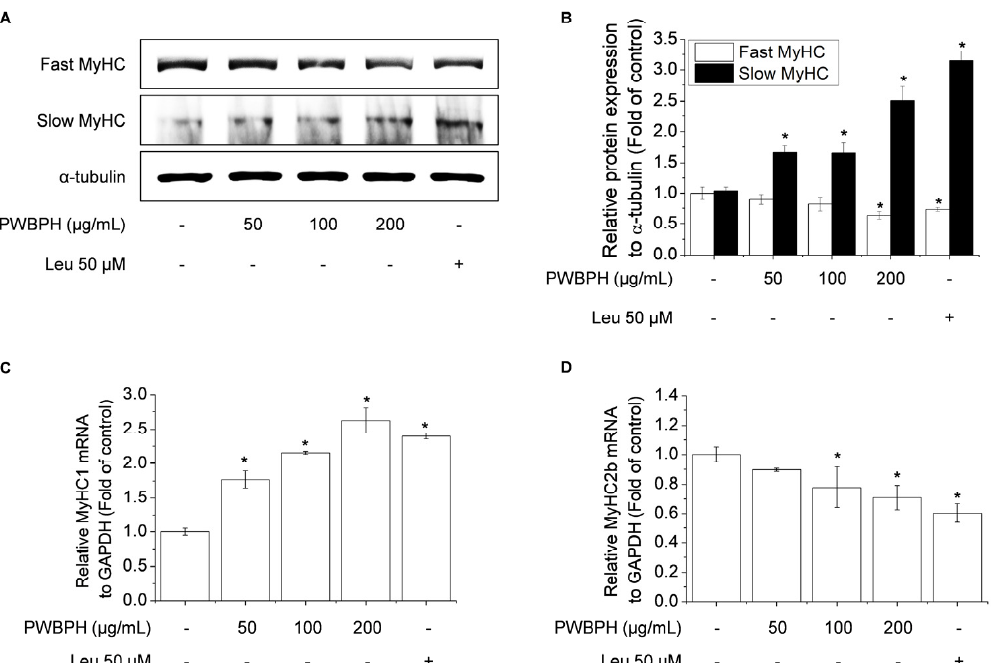
Figure 5. Effect of PWBPH on fast-twitch and slow-twitch muscle fiber-related protein and mRNA levels in C2C12 myotubes. About 90% confluent C2C12 cells cultured in differentiation medium for 4 days and then cells were treated with PWBPH (50, 100, or 200 μ g/mL) and Leu (50 μ M) for 3 days. ( A ) The protein levels of fast MyHC and slow MyHC were determined by Western blotting and ( B ) the band intensities were measured using ImageJ software. ( C , D ) qRT-PCR analysis of the mRNA levels of MyHC1 and MyHC2b. Data are the means ± standard deviation ( n = 3). * p < 0.05 vs. control group.